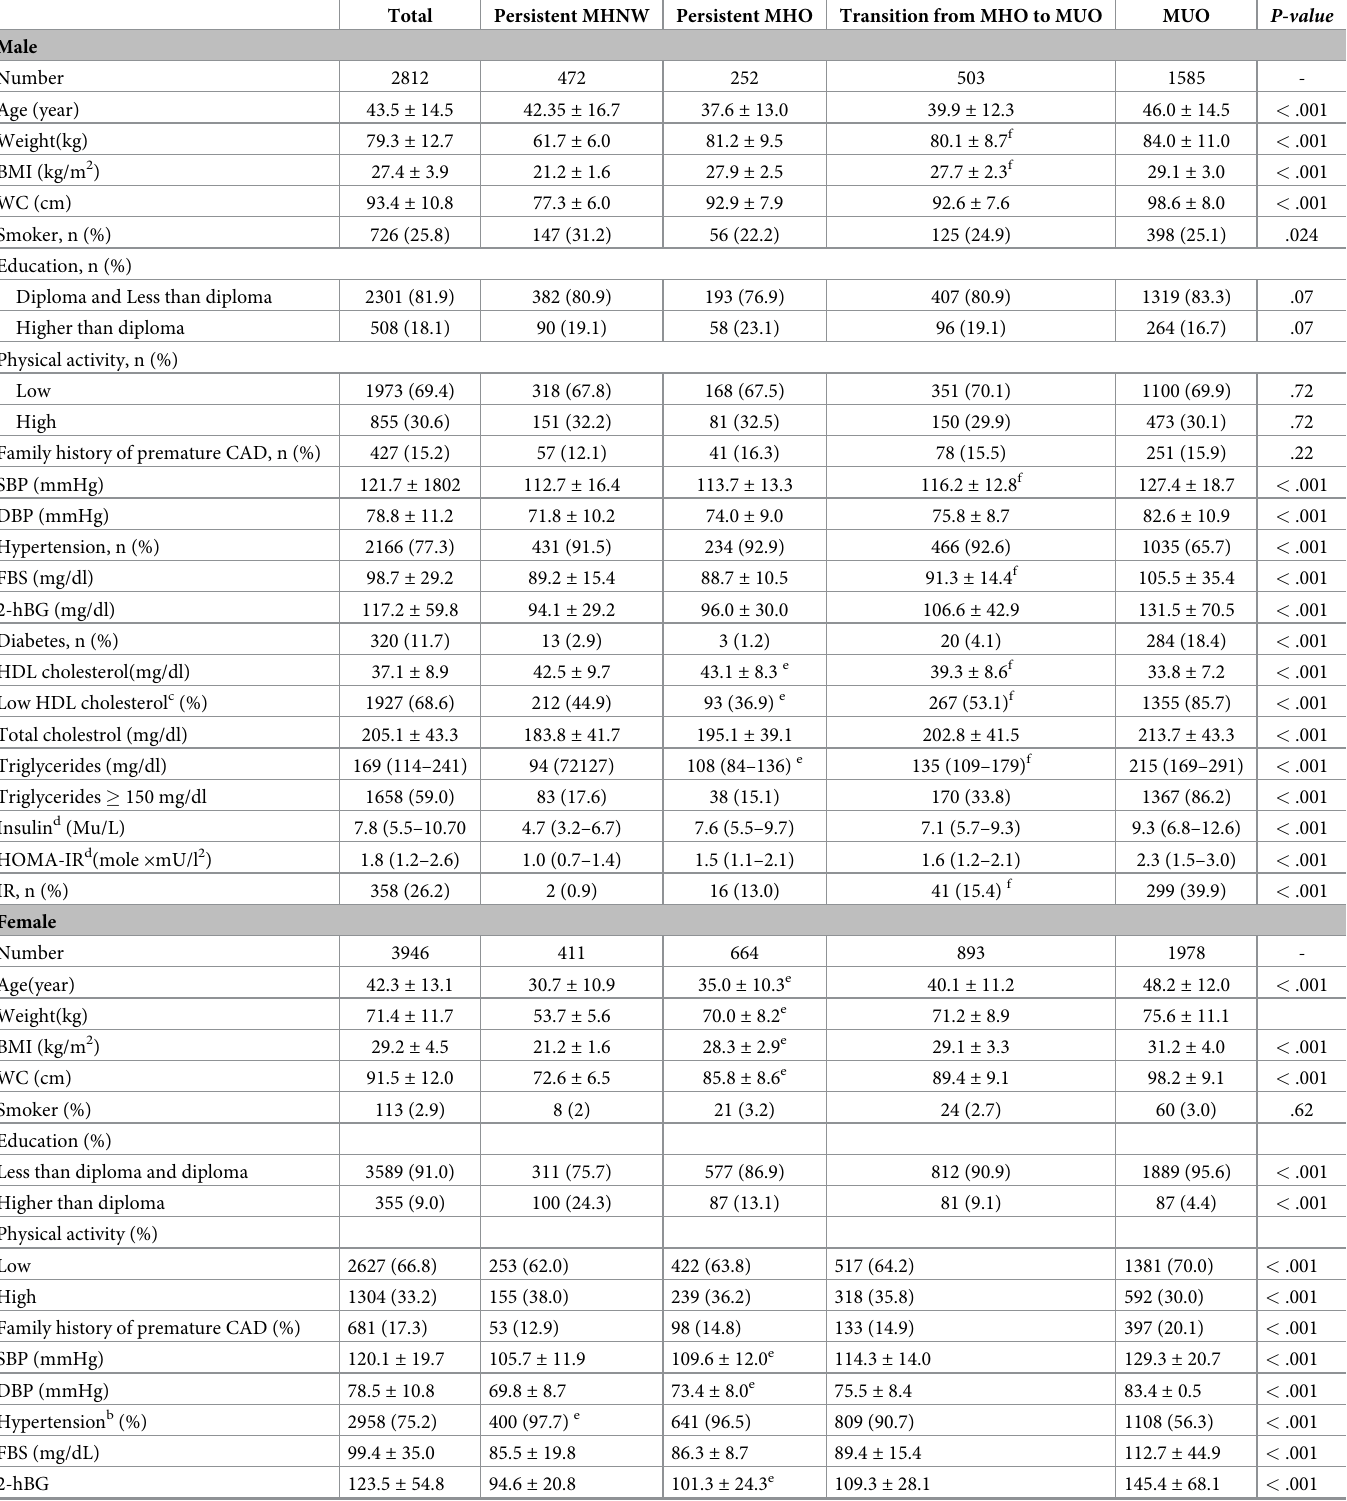
Table 1. Baseline characteristics of 6758 study participants according to obesity phenotypes (body mass index and metabolic health) and